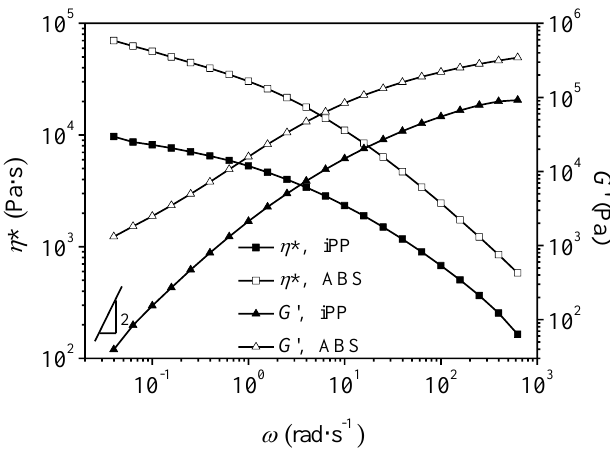
Figure 2. Storage modulus ( G ’) and complex viscosity ( η * ) with respect to angular frequency ( ω ) for pure iPP and